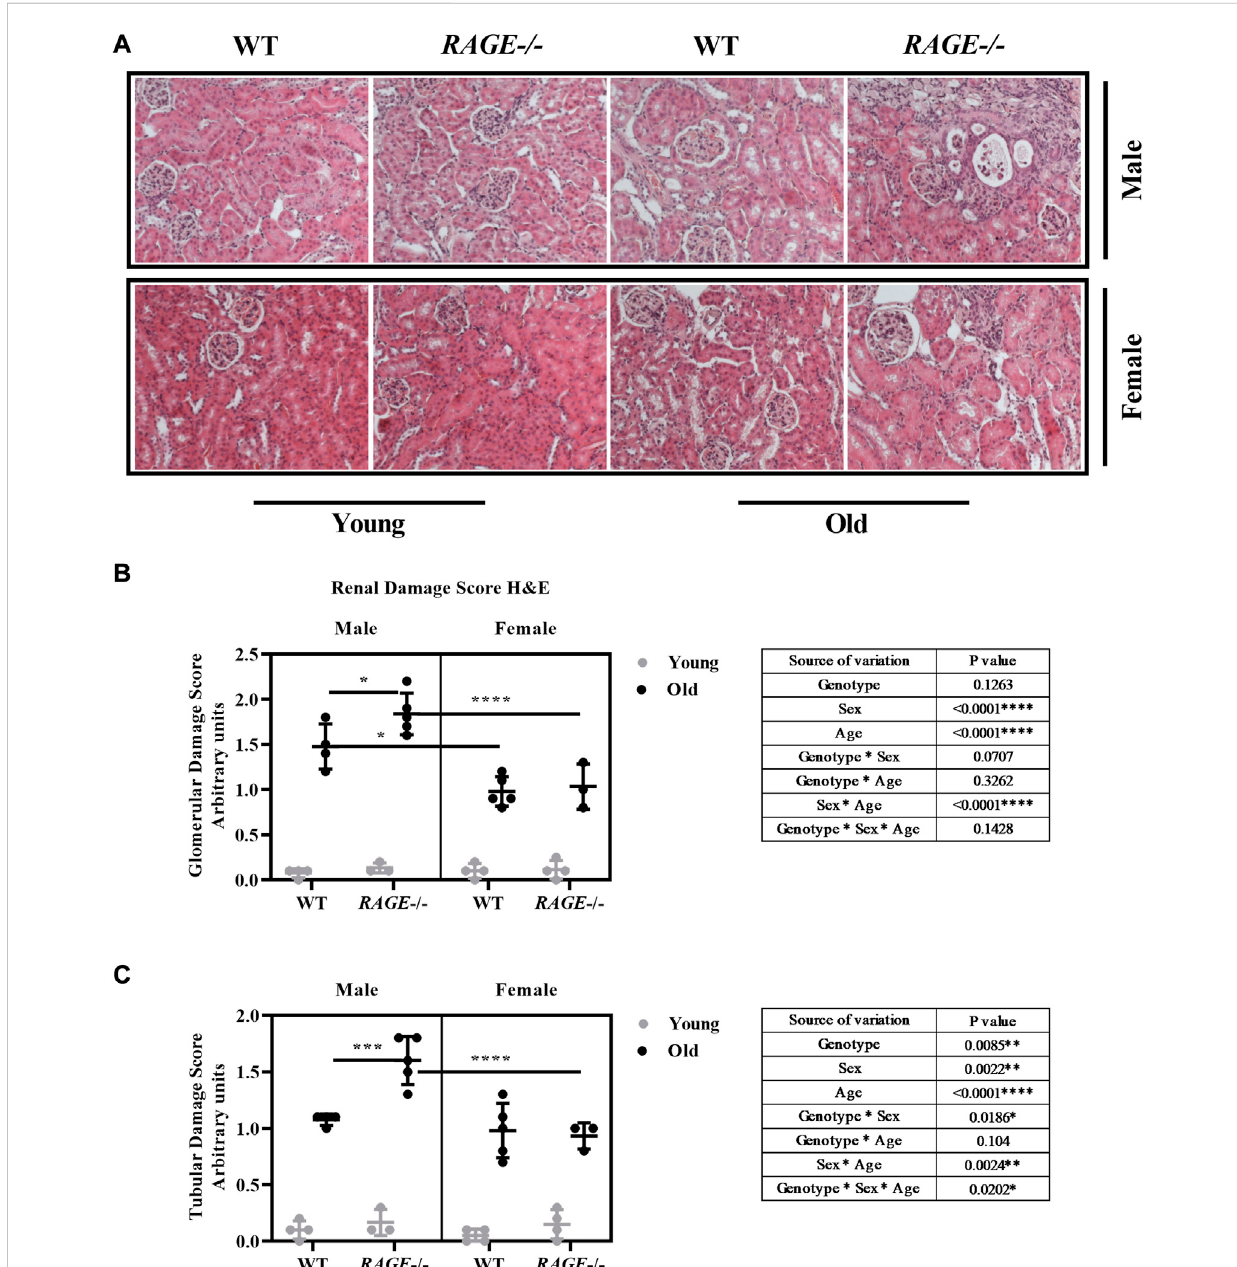
FIGURE 2 Histopathological characterization for renal damage: (A) representative images of kidneys H&E staining from the indicated sex and genotypes, (B) quanti fi cation of renal glomerular damage, and (C) tubular/interstitial damage score. Signi fi cance and interaction were calculated by three-way ANOVA withgenotype(wildtype vs .RAGE − / − ,sex(male vs. female),andage(young vs. old)asthreefactors(shownintableinsert).Sidakmultiplecomparisonstests wereperformedforintergroupsigni fi cance(shownabovebars).Young( < 30 weeks)andold( > 70 weeks)maleandfemalemice( n =3 – 5)wereused in the experiment. Images were taken under ×200 magni fi cation. Data are shown as mean ± SD; p- value: 0.05*, 0.01**, 0.001***, and